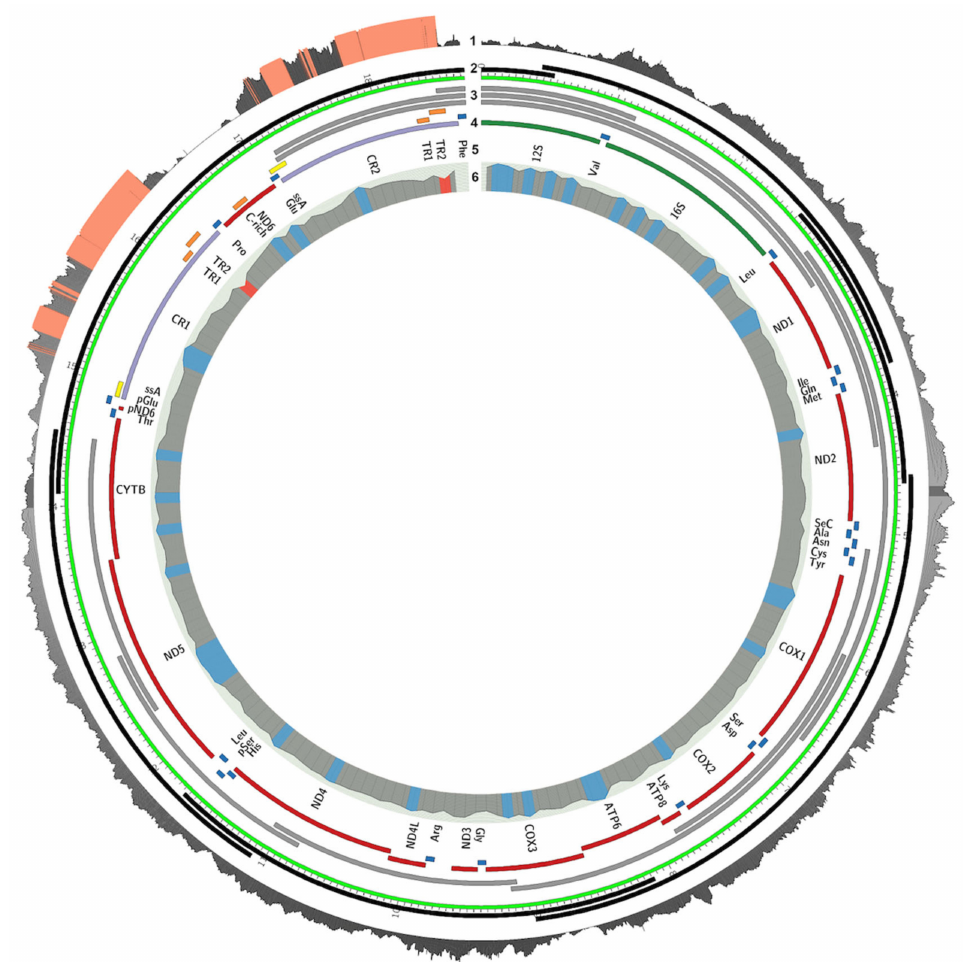
Figure 1. The annotated assembly of the Puerto Rican parrot ( Amazona vittata ) mitogenome. The concentric tracks show (from the outside in): (1) Coverage by mapped Illumina paired-end reads. The orange color indicates a coverage depth of >140 reads/bp; (2) Mapped PacBio reads (black); the green ruler denotes the chromosome and its coordinates; (3) Sanger sequence reads and PCR products used for distance validation; (4) Feature annotations: (red) protein-coding genes, (green) rRNA genes, (blue) tRNA genes, (purple) control region, (orange) tandem repeats, (yellow) ssA; (5) gene names; (6) GC content (red if <30%, blue if >50%). The figure was generated using Circos